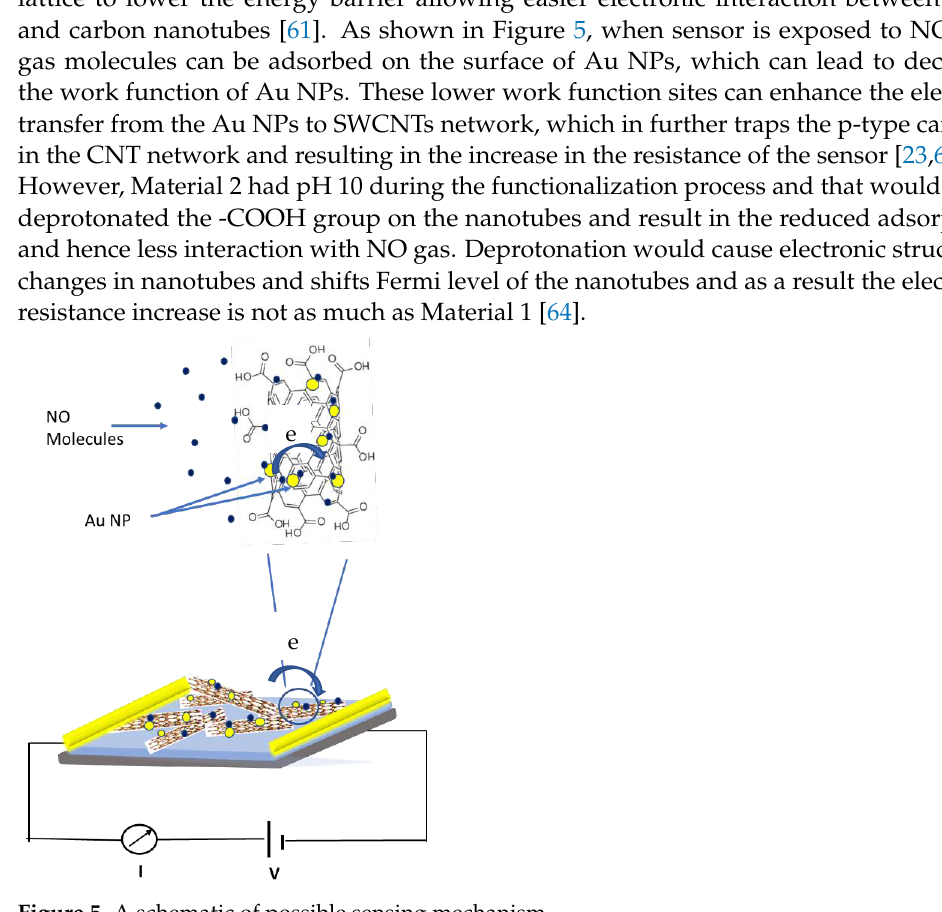
Figure 5. A schematic of possible sensing mechanism.